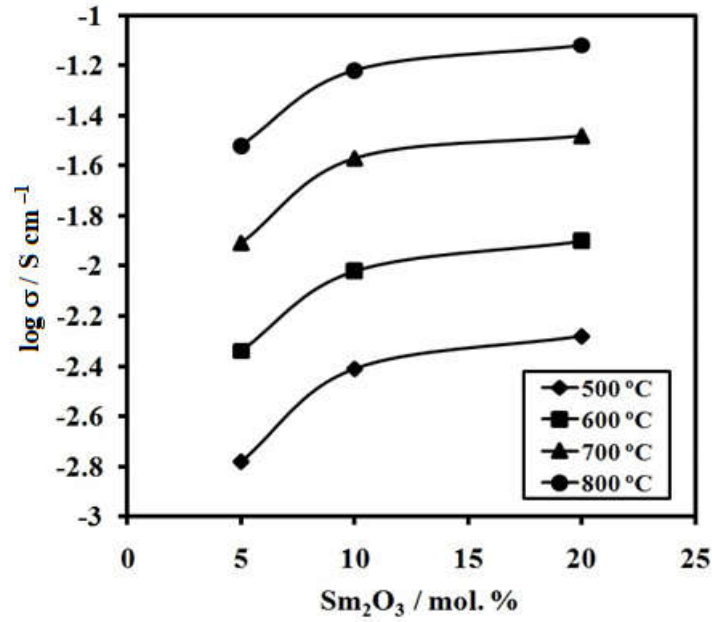
Figure 6. Specific electrical conductivity of ceramics samples at temperatures 500 °C ( ♦ ), 600 °C ( ■ ), 700 °C ( ▲ ) and 800 °C ( ● ) as function of Sm 2 O 3 concentration.